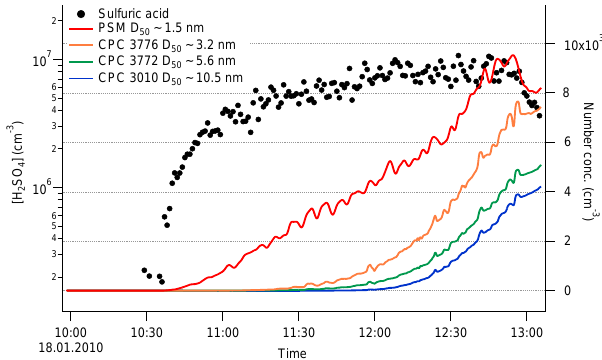
Fig. 1. Example of the time evolution of sulfuric acid concentration (left axis), particle concentration measured by PSM and CPCs (right axis) during α -p 6